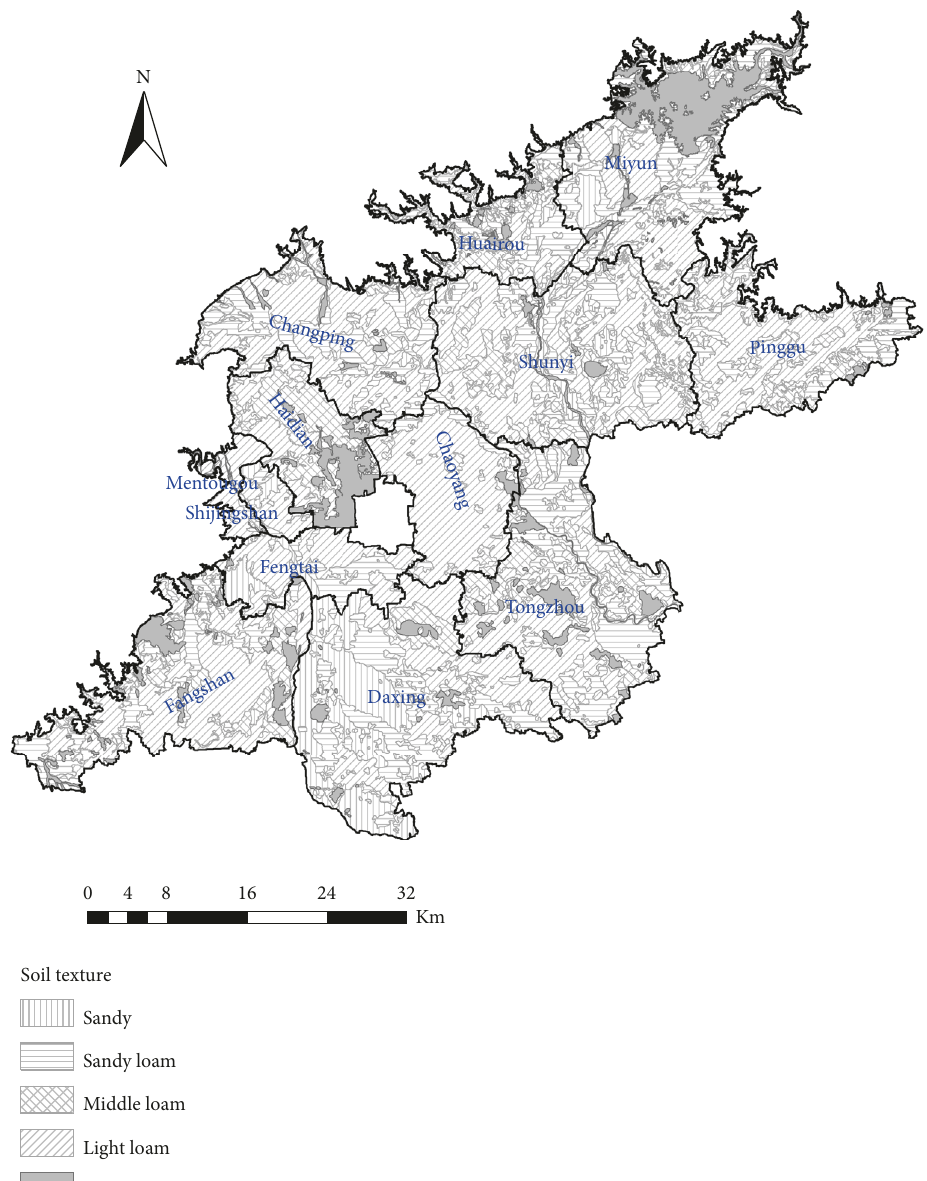
Figure 2: Map of soil texture in the study